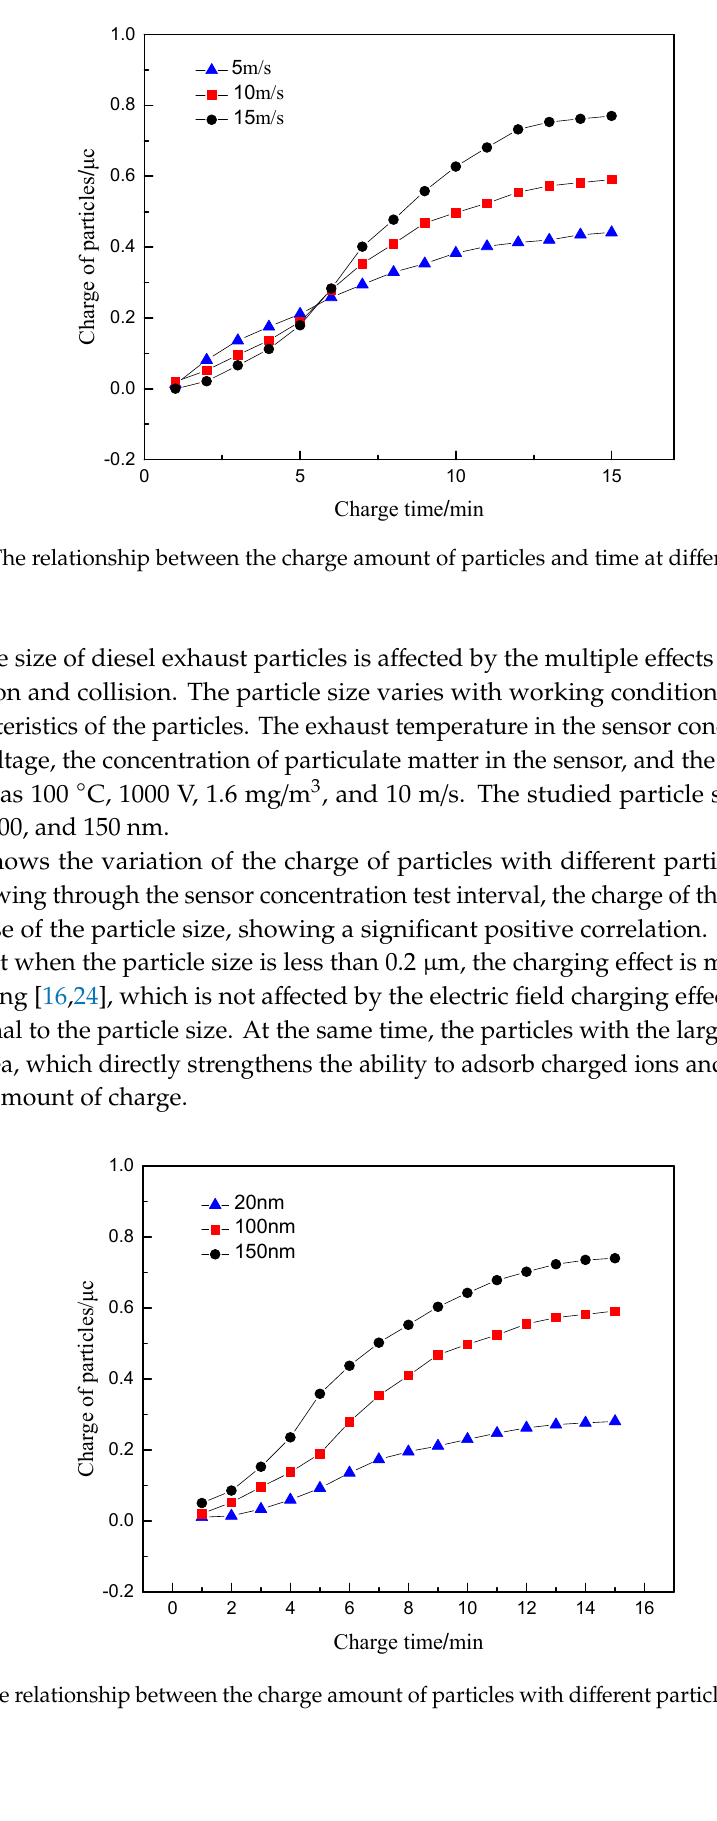
Figure 7. The relationship between the charge amount of particles with different particle sizes and time.